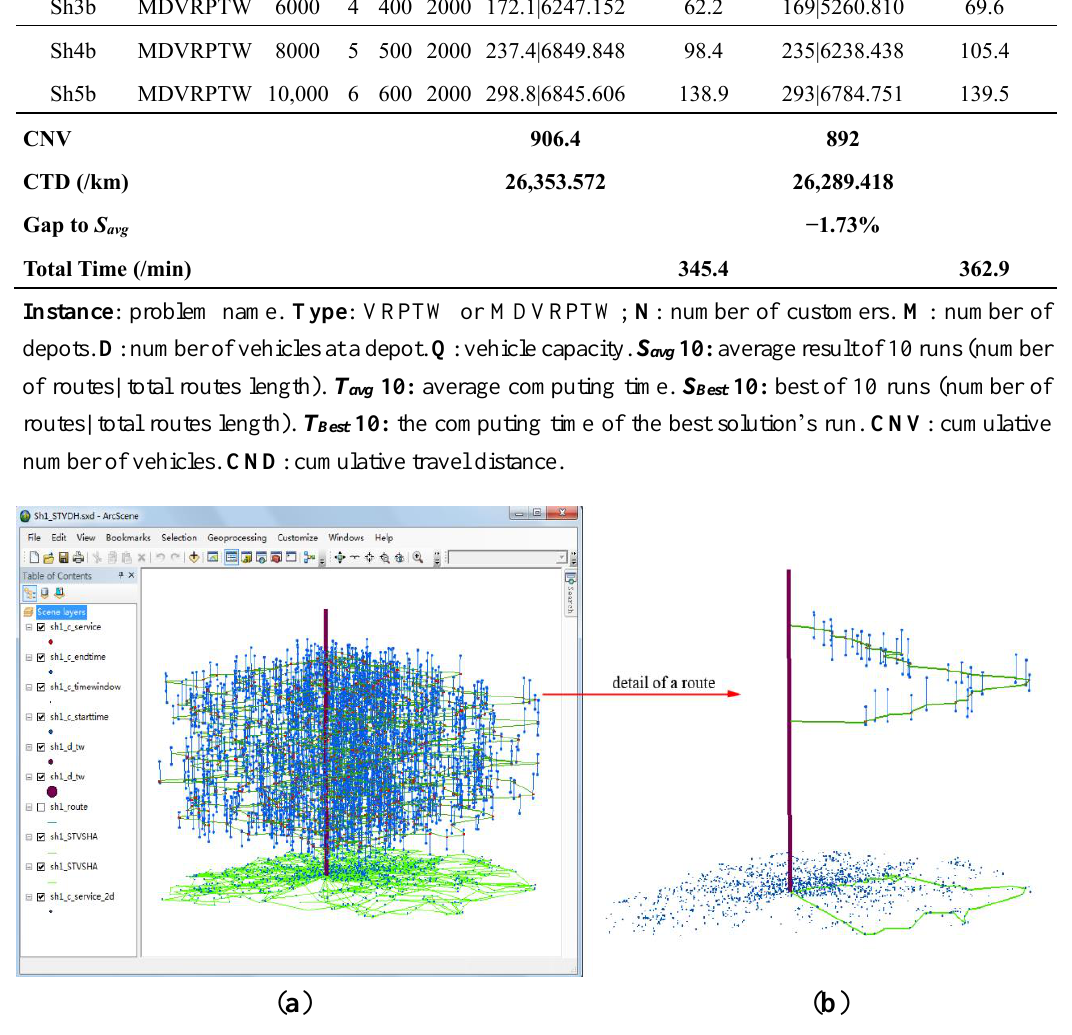
Figure 9. The result for large scale VRPTW problem Sh1a. ( a ) the final best solution; and ( b ) a spatial-temporal